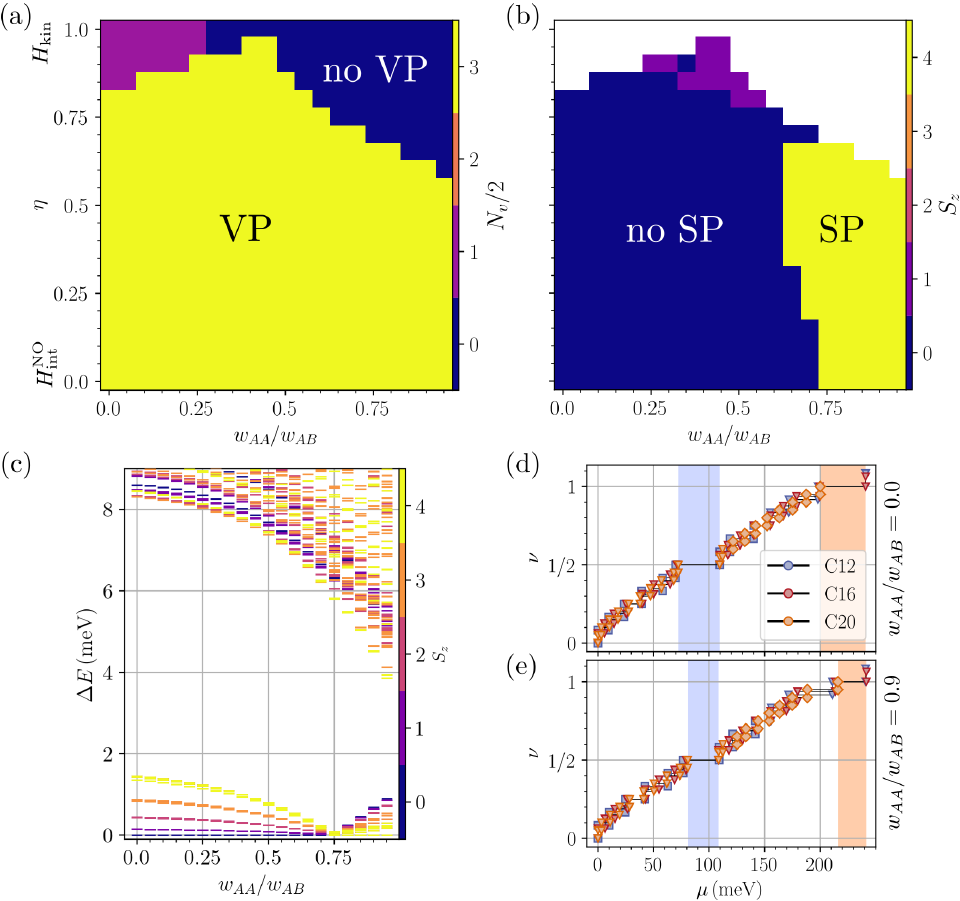
Figure 3: Valley (a) and spin (b) polarization extracted from the lowest energy levels from ED provide evidence for the transition from a time-reversal symmetry break- { w » 0.7. (c) ED ing singlet (no SP) to a fully spin polarized (SP) state near w AA AB spectrum along the η “ 0 (flat band) slice in (b), corresponding to a pure interac- tion Hamiltonian. The low lying levels below 2 meV encode the “tower of states”, a clear spectral signature for the pattern of continuous symmetry breaking discussed in the main text. (d)–(e) In addition to ν “ 1 band filling (orange shaded region), the prominent plateau at ν “ 1 { 2 (blue shaded region) as a function of the calcu- lated chemical potential [ defined in Eq. (20) ] points to an incompressible, insulating { w “ 0.0 as well as (e) w { w “ 0.9. The used phase at ν “ 1 { 2 for both (d) w AA AB AA AB simulation clusters are (a) C12, (b)–(c) C16 and (d)–(e) disclosed in the legend of (d). Square / triangular / diamond shaped markers in (d) and (e) indicate data from spin and valley resolved / valley polarized / spin and valley polarized